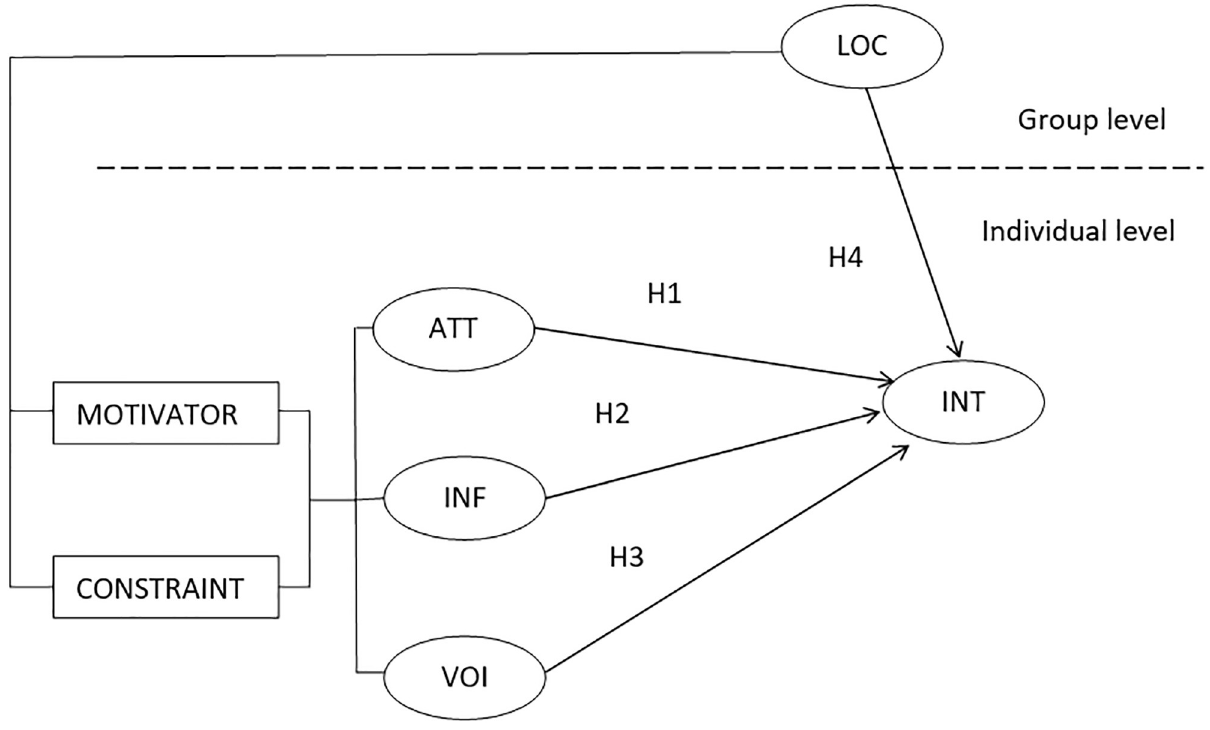
Fig 1. The conceptual